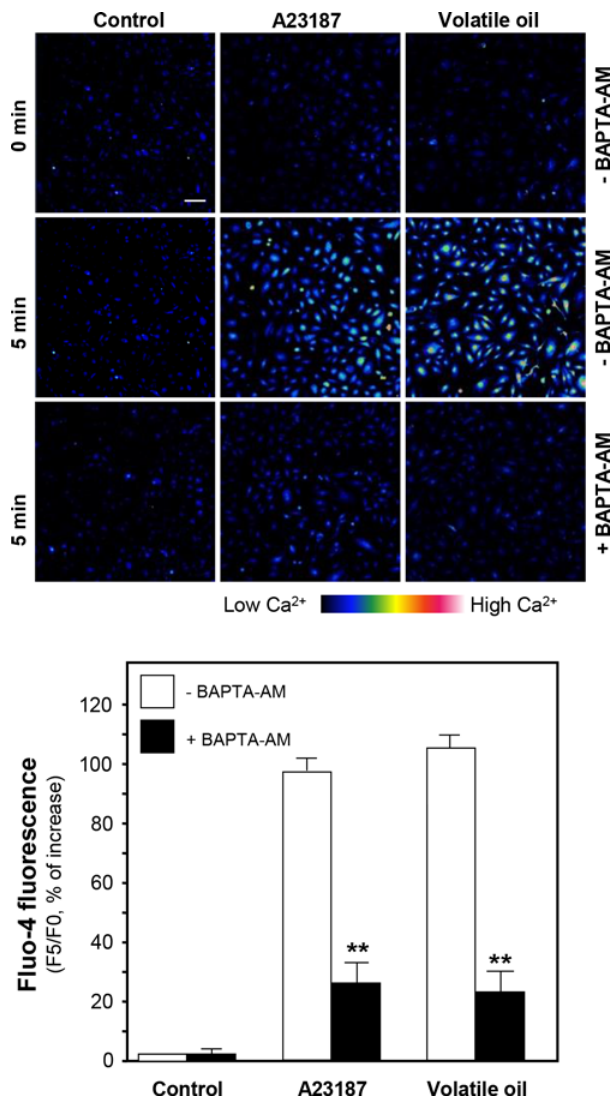
Figure 6. NRR volatile oil induces Ca 2+ mobilization in HUVECs. Cultured HUVECs were labeled with fluorescent Ca 2+ indicator Fluo-4 AM for 30 min. Fluorimetric measurement was performed after the treatment of NRR volatile oil (25 µ g/mL), A23187 (1 µ M, positive control) or control (untreated culture) (upper panel). Bar = 100 µ m. Quantification of Ca 2+ mobilization was displayed as a ratio of fluorescence intensity